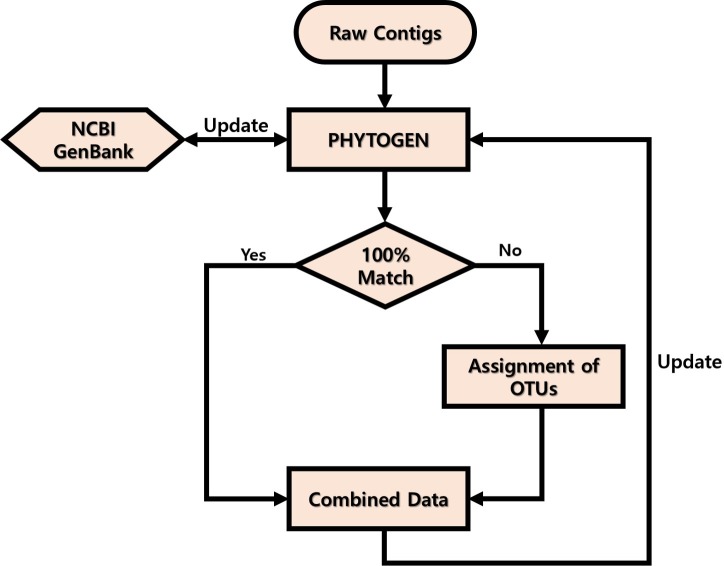
Workflow of PHYTOGEN database process.